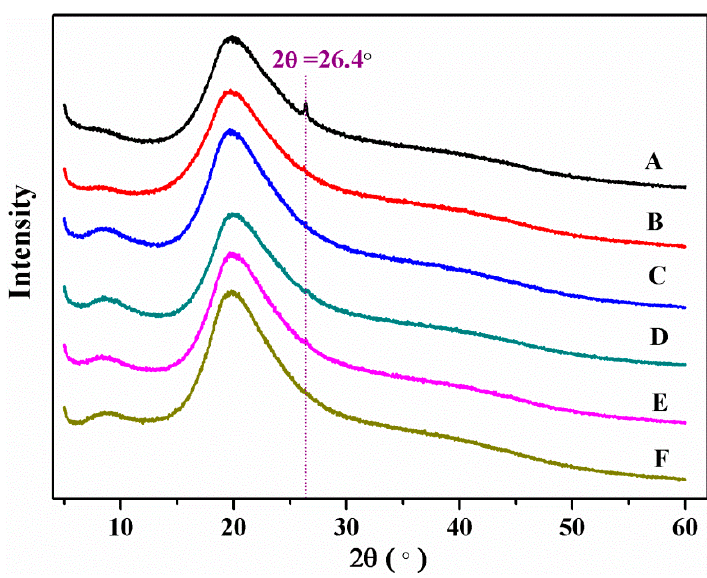
Figure 4. XRD patterns of different SPI-based films.